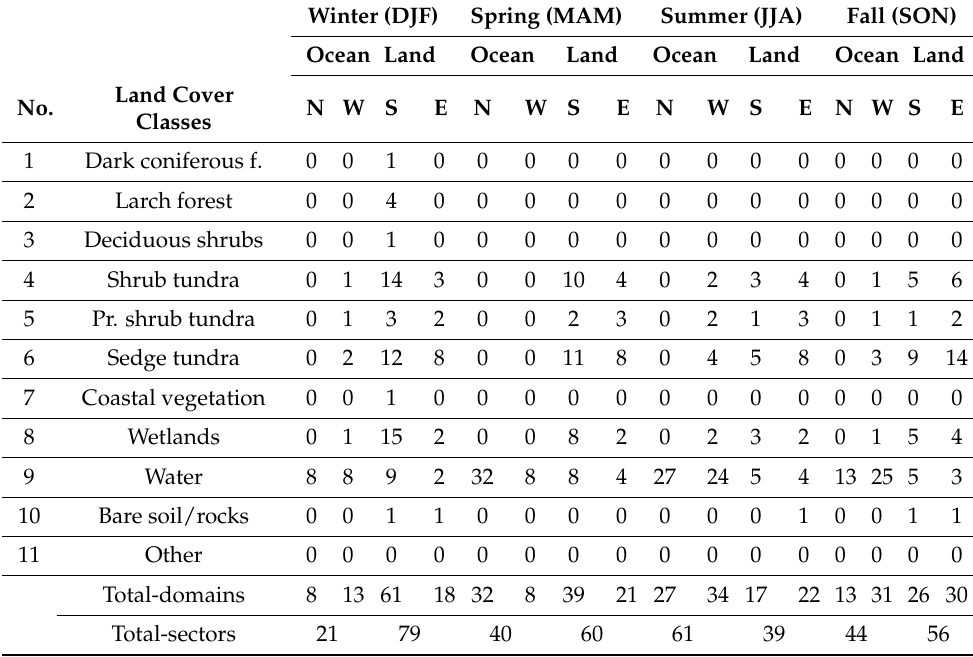
Table 2. Land cover classes (%) in the footprint (Terra Norte RLC 2014) throughout the seasons, arranged to geographical domains and